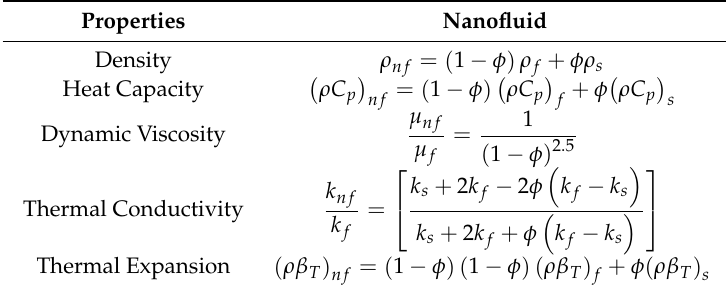
Table 2. The thermophysical properties for nanofluids (see Brinkman [56], Xuan and Li [57], Maxwell-Garnett [58], Das et al. [59], and Oztop and Abu-Nada [60]).